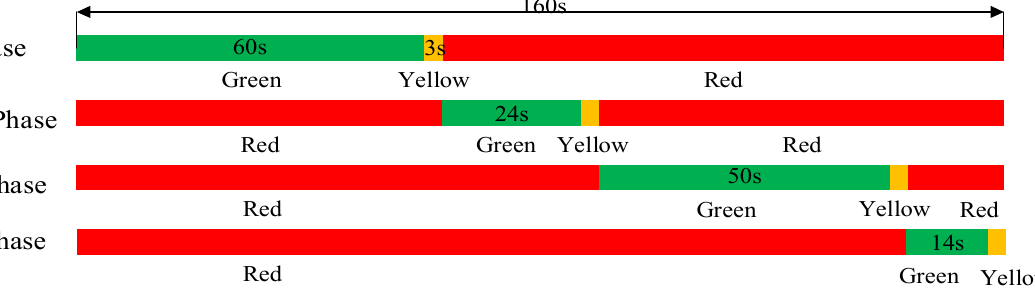
Figure 11. Phase timing diagram at No. 3 intersection.